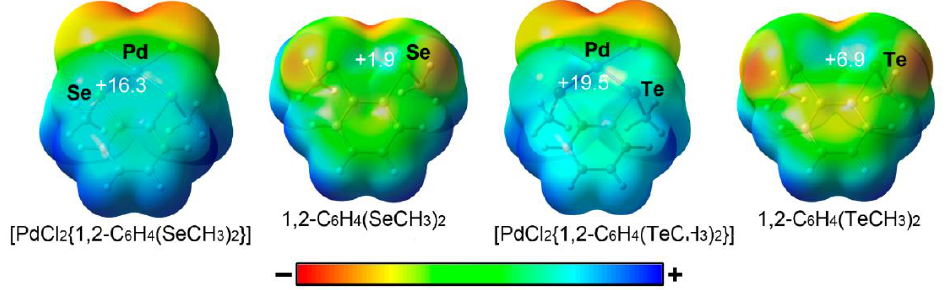
Figure 2. MEP surfaces of [PdCl 2 {1,2-C 6 H 4 (ChCH 3 ) 2 }] and 1,2-C 6 H 4 (ChCH 3 ) 2 (Ch = Se and Te) molecules. The energy values at concrete points of the surface are given in kcal/mol (0.001 a.u.). In this context, the Cambridge Structural Database (CSD) [80] has been inspected and